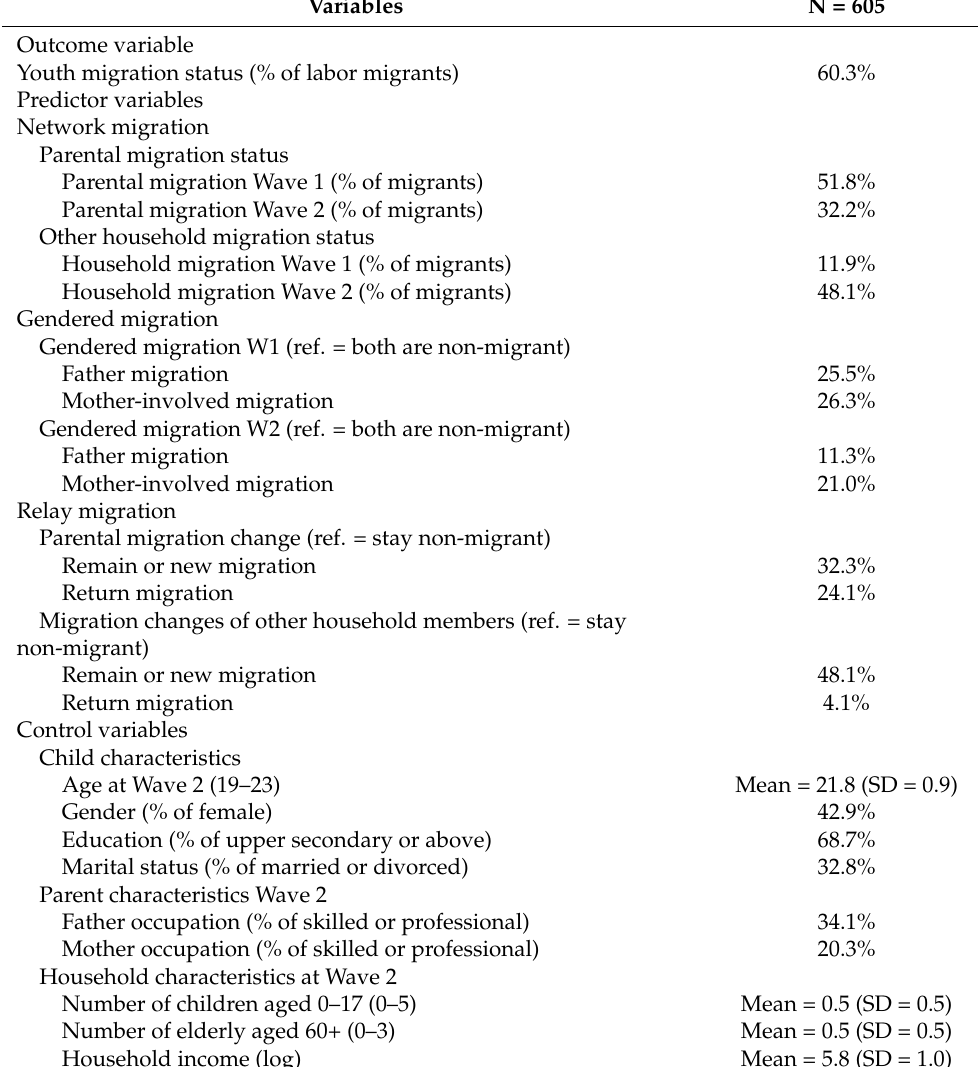
Table 2. Descriptive statistics of sampled